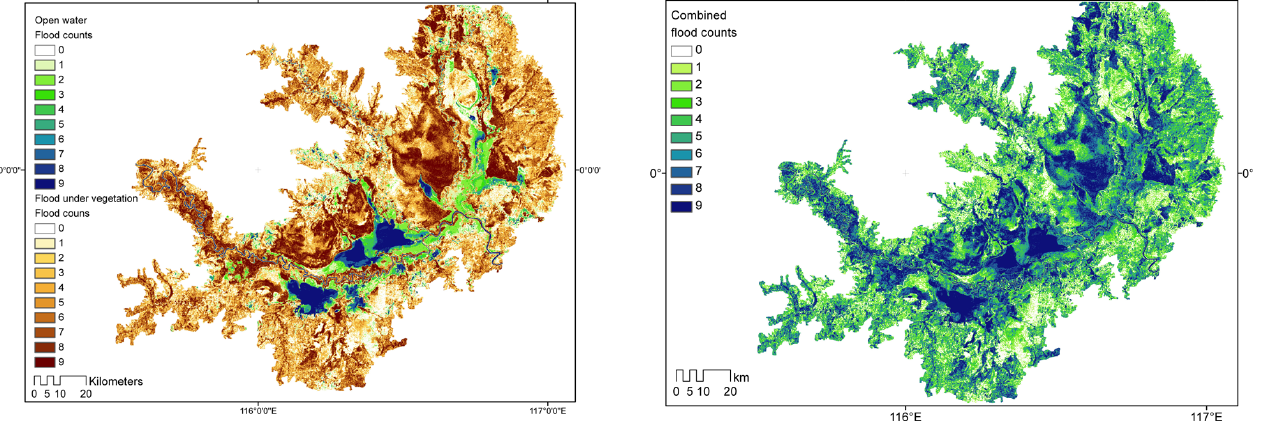
Fig. 16. Combined flood occurrence map of the Kutai wetlands from nine PALSAR images collected in 2008 and 2009, counting the total number of flood cases per pixel, which represents both open water and flooding under